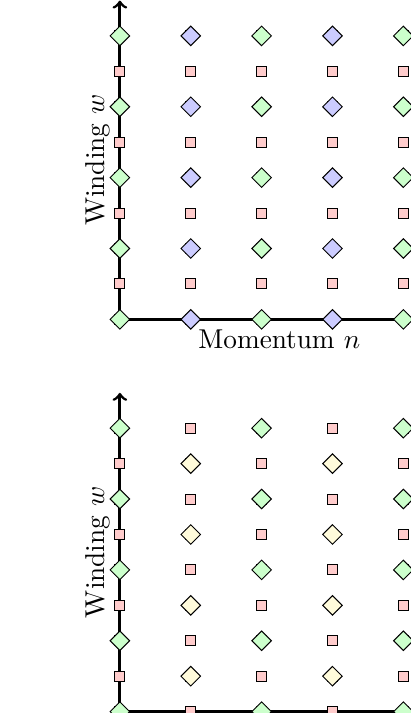
Figure 13 . Green diamonds denote the invariant sublattice Λ under the Z n red squares denote the dual lattice Λ ∗ and have integral spacing along momentum and half-integral spacing along winding. We see that there are only three ways to extend Λ into Λ ∗ : S 1 [ R ] corre- sponds to the extension by the blue diamond, S 1 [ R/ 2] by the cyan diamond, and Dirac yellow